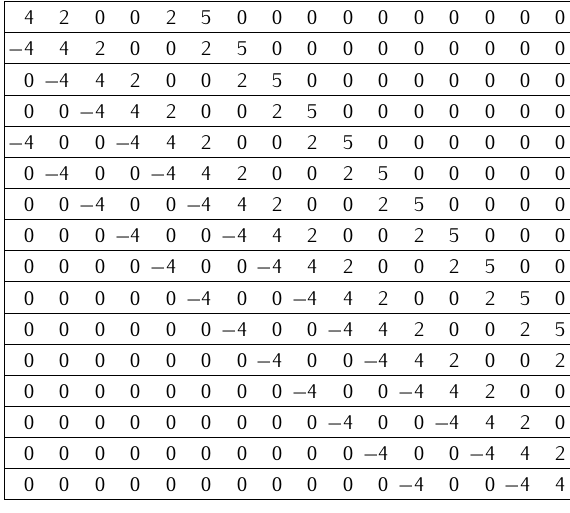
Table 4. A matrix created by using the matrix generator with N